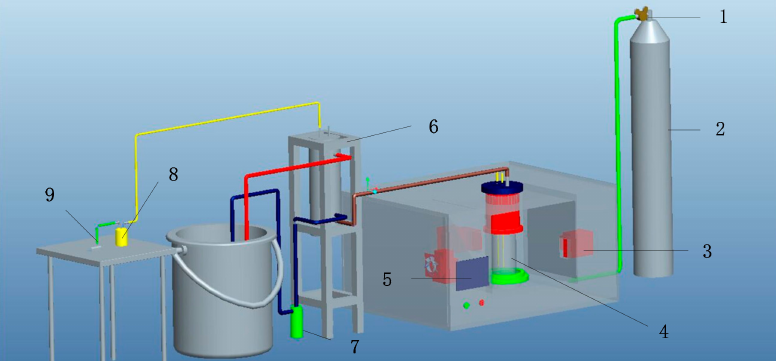
Figure 2. The microwave pyrolysis system: (1: relief valve; 2: nitrogen; 3: microwave generator; 4: reaction chamber; 5: control unit; 6: condenser; 7: circulating pump; 8: gas filter; 9: gas-collection